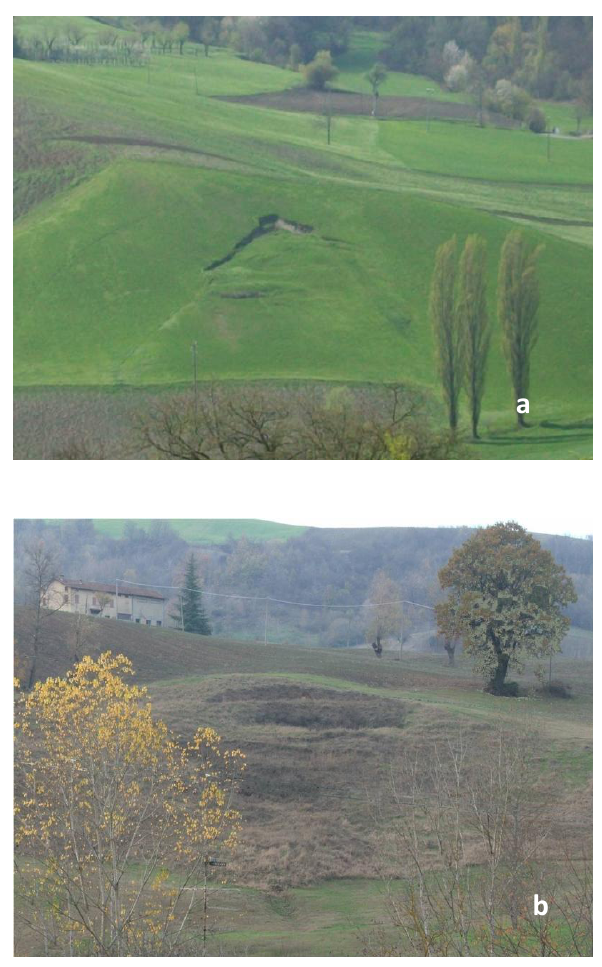
Fig. 1. Some examples of soil slips occurred in the Emilian Apen- nine in April 2005: (a) Regnano and (b)